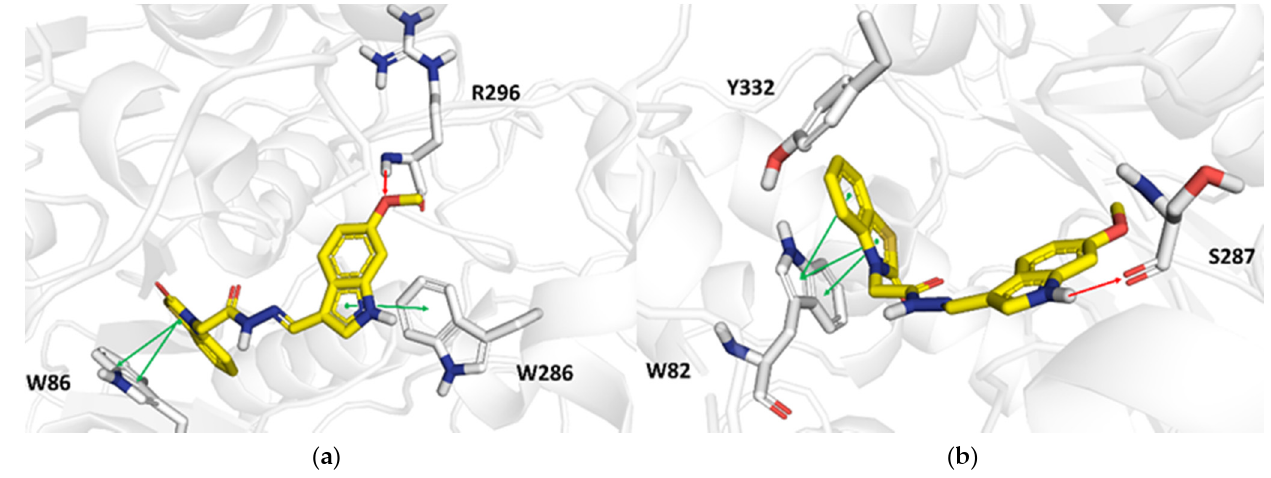
Figure 6. Docking poses carried out from docking analyses of the M13 compound towards hAChE (PDB entry: 4EY7) ( a ) and hBChE (PDB entry: 6RUA) ( b ), respectively. Green and red arrows indicate π−π interactions and hydrogen bonds, respectively. Ligands and the target residues of the binding sites are rendered in yellow and gray sticks, respectively. For the sake of completeness, all the molecular interactions observed in the docking simulations were automatically flagged by GLIDE software.